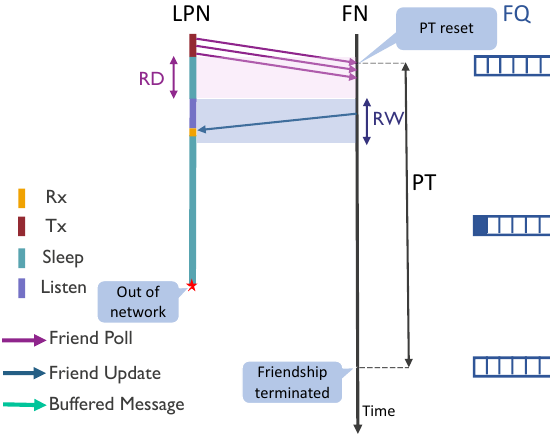
Figure 4. Friendship termination by the